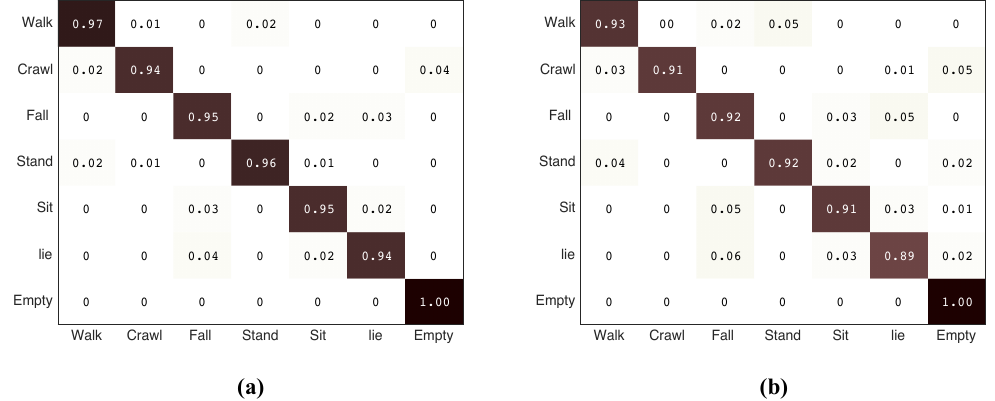
Figure 6. Confusion matrices for the activities classification. ( a ) confusion matrix for Line-of-Sight (LOS); and ( b ) confusion matrix for Non-Line-of-Sight (NLOS). Researchers have used numerous classification algorithms to build activity classification models.